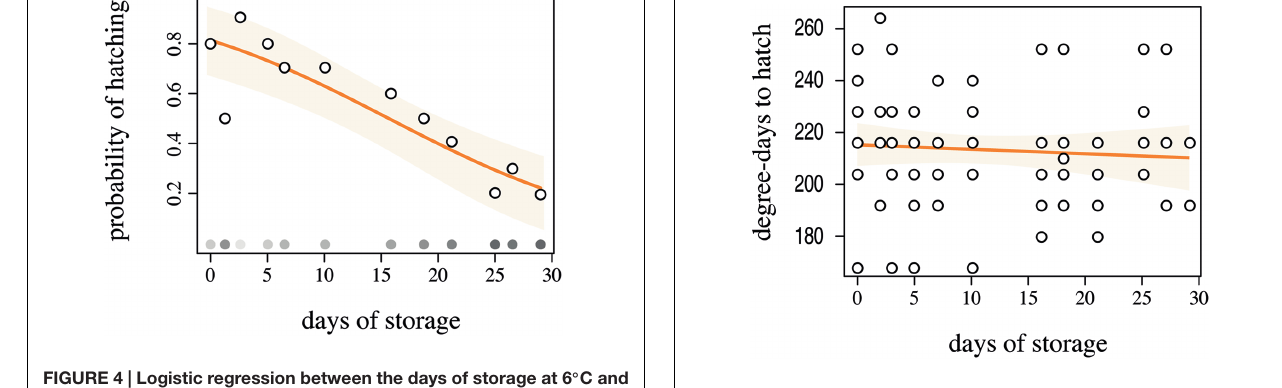
FIGURE 5 | Linear regression between the days of storage at 6 ◦ C and the degree-days required for Heteronychus arator eggs to hatch after removal from storage. Open circles indicate the observed data. The light orange zone represents the 95% confidence interval of the fitted model (orange solid